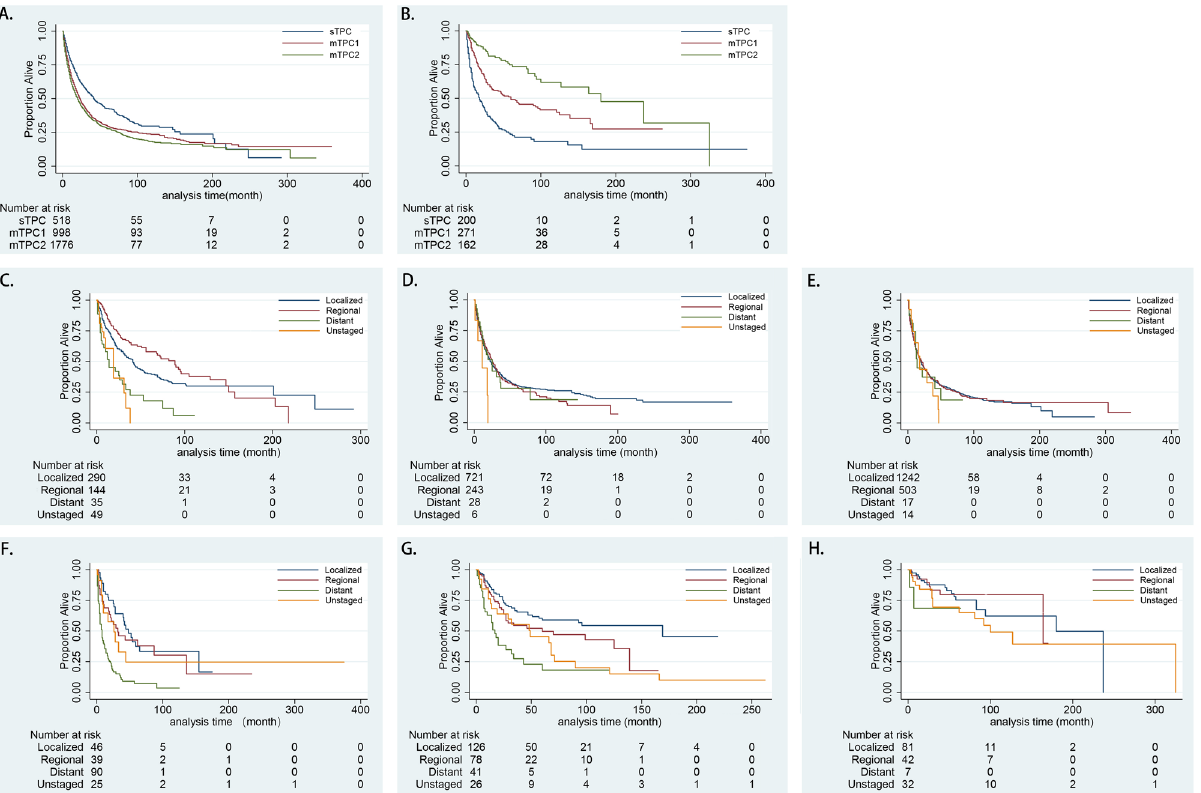
Figure 1. ( A ) Survival estimates of BCLA since secondary diagnosis stratified by group sTPC, mTPC1 and mTPC2; ( B ) Survival estimates of LABC since secondary diagnosis stratified by group sTPC, mTPC1 and mTPC2; ( C – E ) Survival estimates of BCLA in respective group sTPC, mTPC1 and mTPC2 since secondary diagnosis stratified by breast cancer stage; ( F – H ) Survival estimates of LABC in respective group sTPC, mTPC1 and mTPC2 since secondary diagnosis stratified by breast cancer stage.